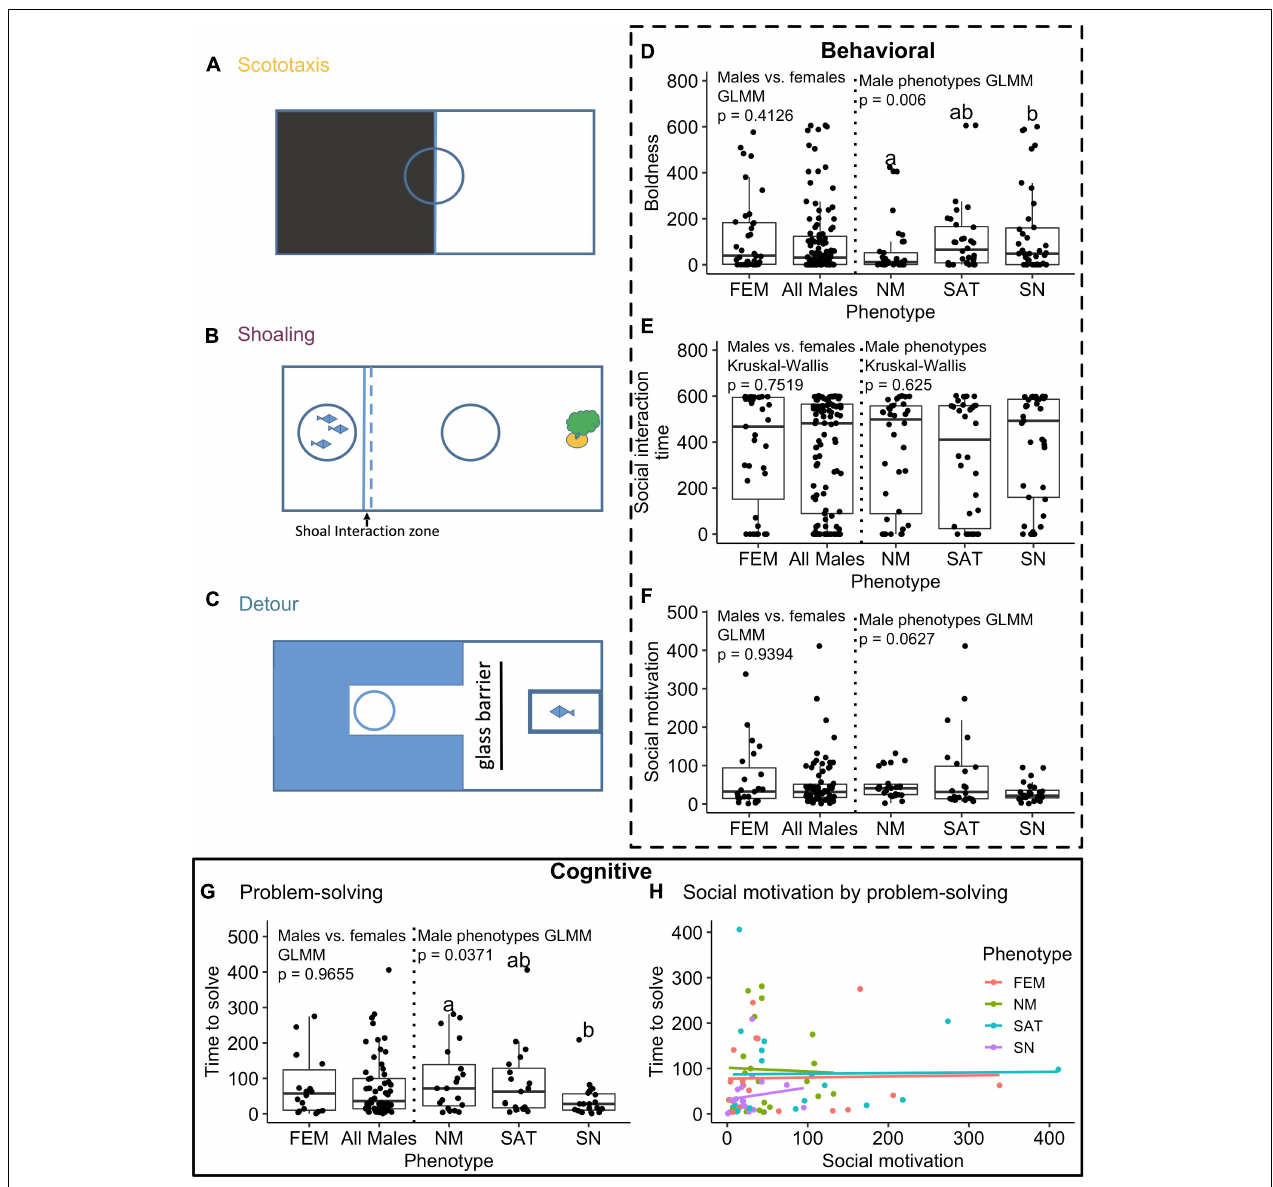
FIGURE 1 | Aerial views of experimental assays (A–C) , behavioral metrics (D–F) , and cognitive performances (G,H) for all phenotypes. All experimental arenas were 98 cm × 28 cm × 24 cm. Scototaxis assays were run in an aquarium with half of the tank felted in black and the other half felted in white, with habituation cylinder (blue circle) placed at the midline between each half (A) . Boldness was evaluated as the time (seconds) spent in the white half of the scototaxis tank (D) . Shoaling assays were conducted in a tank with a transparent barrier between a shoal group (three conspecific females in a transparent cylinder) and the region of the tank wherein the focal fish was free to roam (B) . The habituation cylinder (blue circle) was placed mid-way between social interaction zone [1 cm away from the shoal barrier (see dotted line) and the plant positioned at the far end of tank]. Shoaling assays were used to measure both social interaction time (seconds) spent within 1 cm of the shoal barrier (E) , and social boldness (proportion of time spent in open region of the tank (excluding social interaction zone) relative to time spent in plant). Each focal fish ran through a detour reaching assay wherein fish were released from a habituation cylinder at the back end of an alley and allowed to navigate around a glass barrier to arrive at a social reward [a female conspecific in a transparent container placed at the opposite end of the tank, (C) ]. From these detour assays, we collected one behavioral measure: social motivation, latency time (seconds) to reach glass barrier after release from habituation tube, (F) , and problem-solving, time (seconds) from barrier to social reward (time to solve) in the detour task, (G) . We plot the relationship between social motivation (time to barrier) and problem-solving speed (time from barrier to social reward) in detour task [ r = 0.07, p = 0.55, (H) ]. Bar graphs (D–G) represent box and whisker plots with midline representing the median value and upper and lower box lines representing upper and lower quartiles, respectively. Statistical comparisons between the sexes and the alternative male reproductive phenotypes (NM, nesting male; SAT, satellite male; SN, sneaker male) were evaluated with either GLMM models or Kruskal-Wallis based on normality criteria. Post-hoc Tukey tests across alternative male mating phenotypes reveal pairwise differences between phenotypes by different letters.